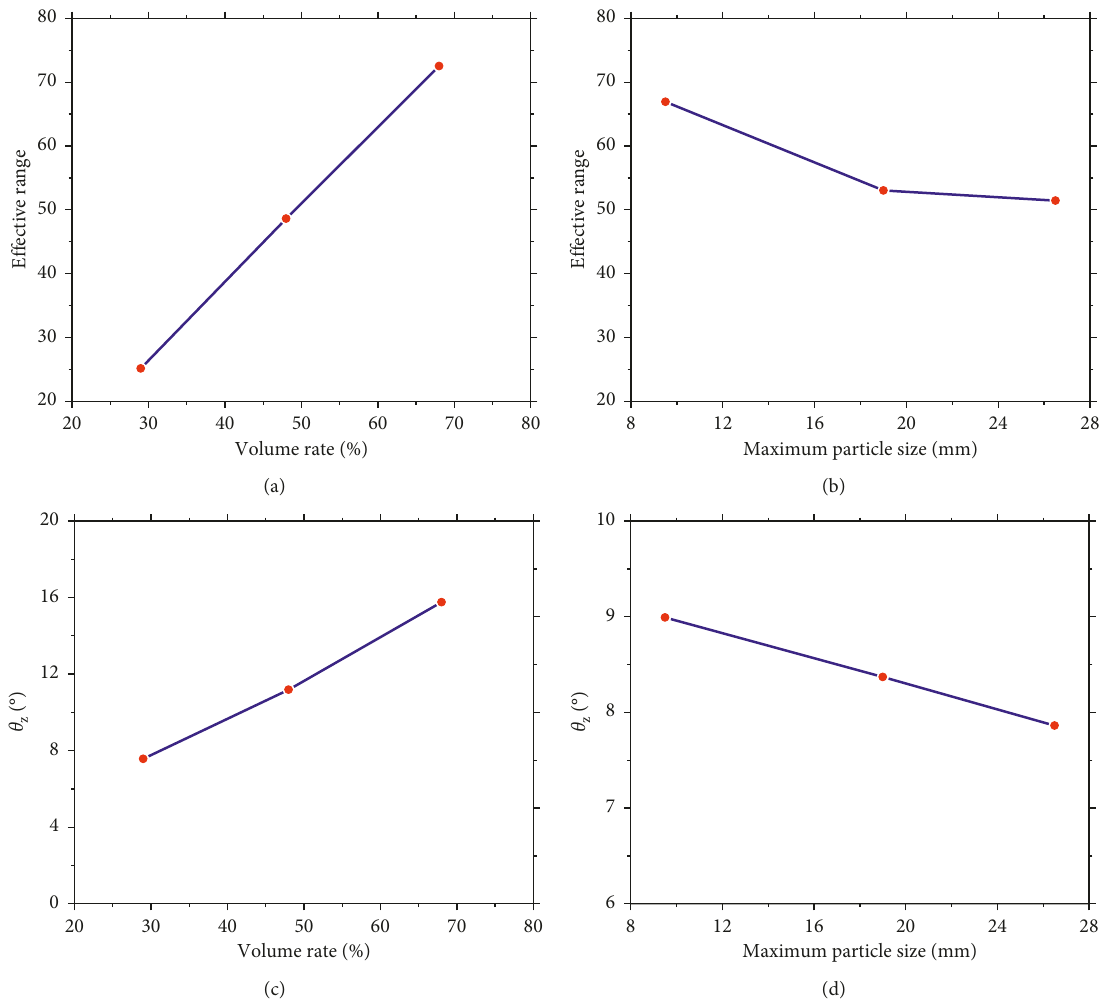
Figure 11: (a) Volume rate and valid field of the initiation angle; (b) maximum p size and valid field of the initiation angle; (c) volume rate and θ z ; (d) maximum particle size and θ z .